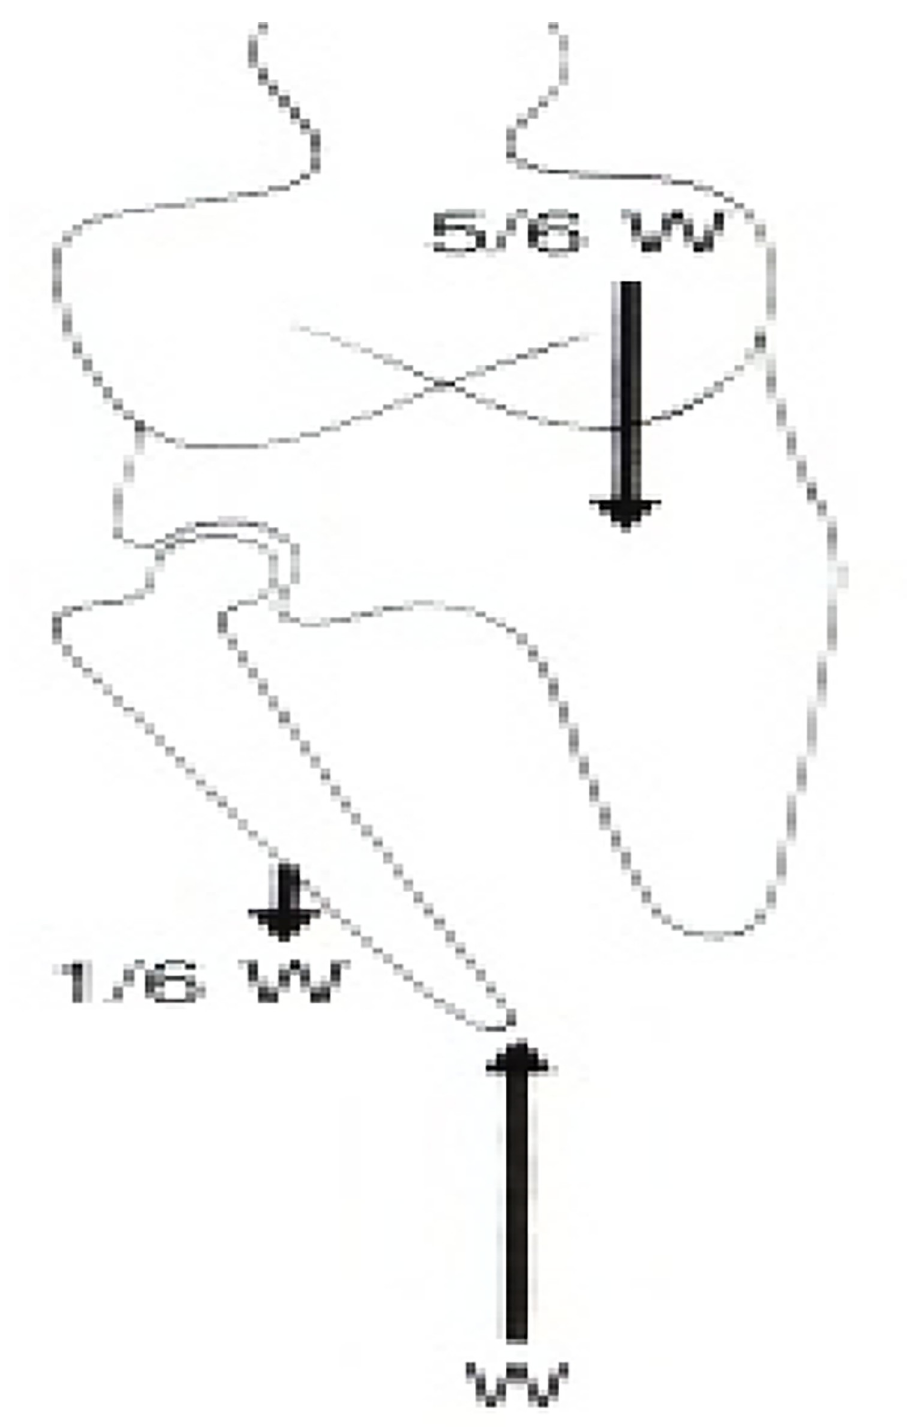
Fig 9. Free body diagram showing the perpendicular orientation of GRF for the forces acting on the body. (Adapted from Frankel and Nordin 2001).